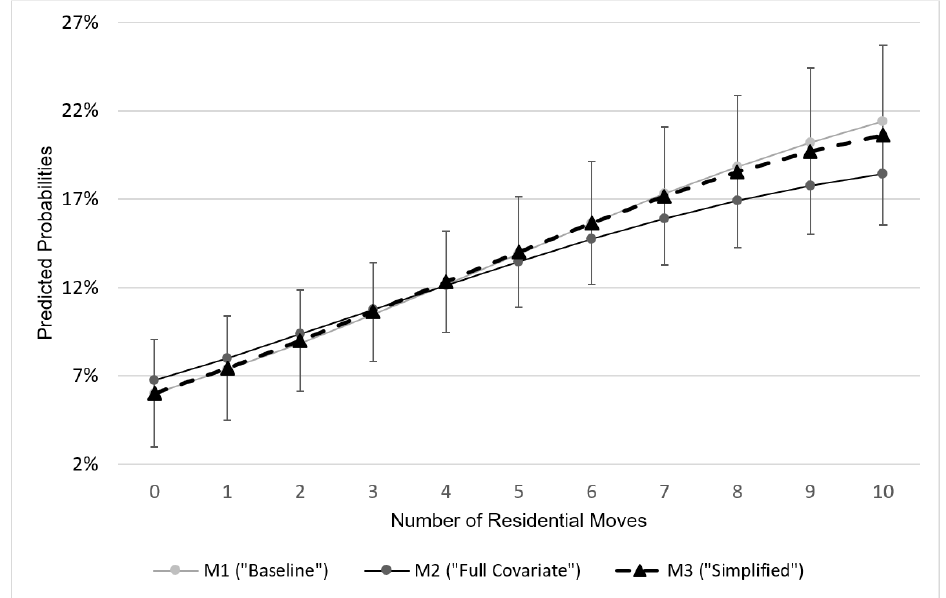
Figure 2. Predicted probabilities of past-year major depressive episodes among US mothers by number of residential moves during the first 15 years after a nonmarital birth, Fragile Families and Child Wellbeing Study (n =